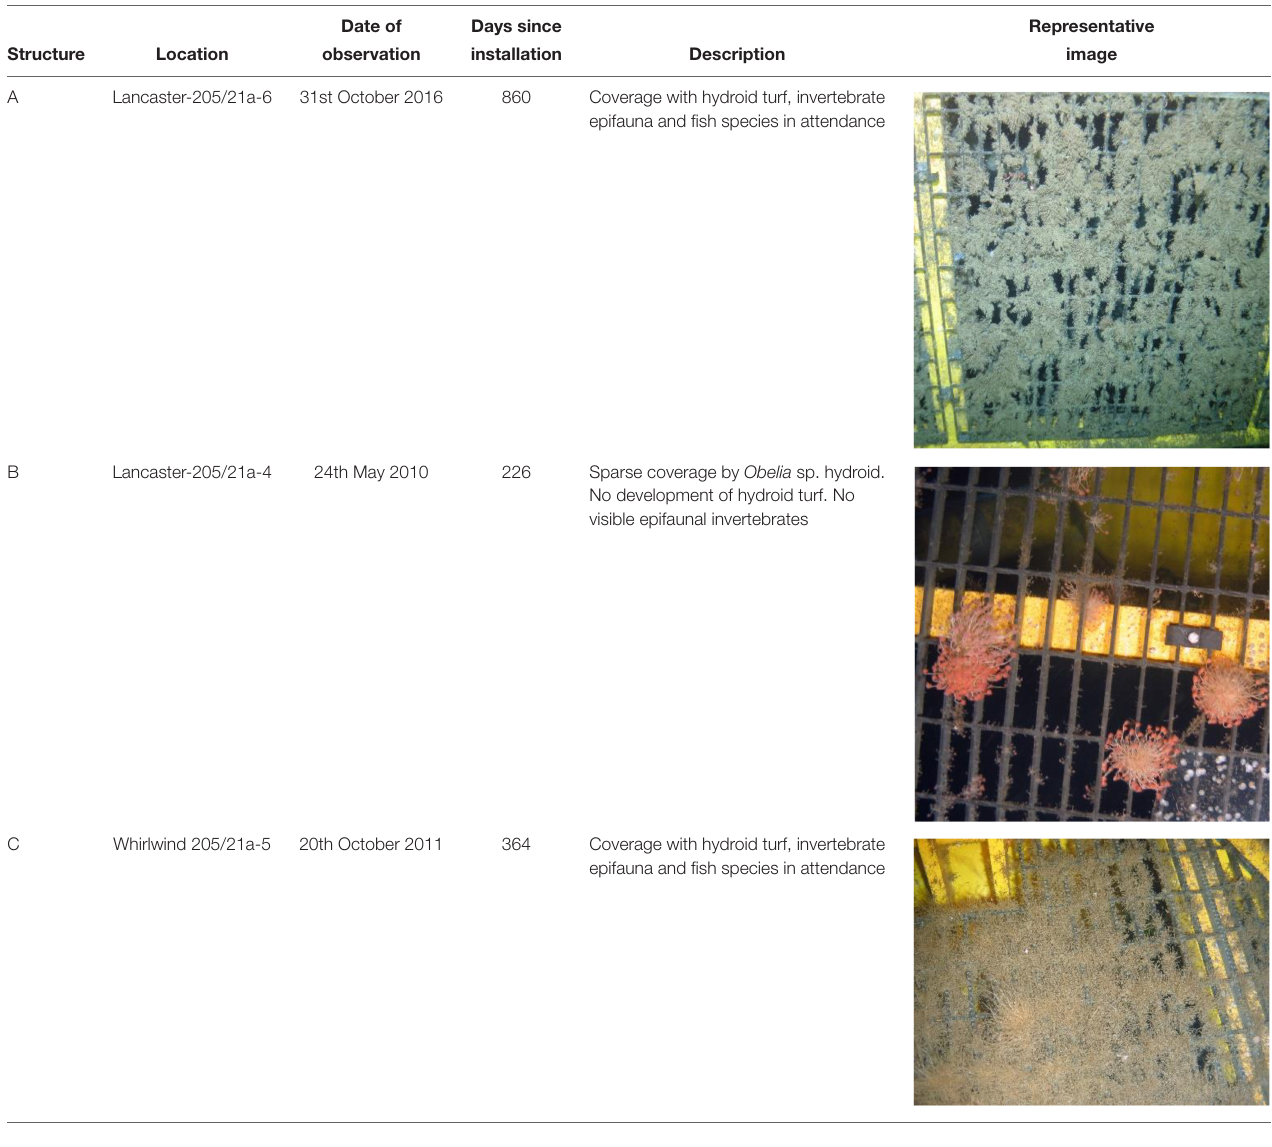
TABLE 4 | Dimension to fresh wet weight relationships from specimens used to calculate biomass on structure.